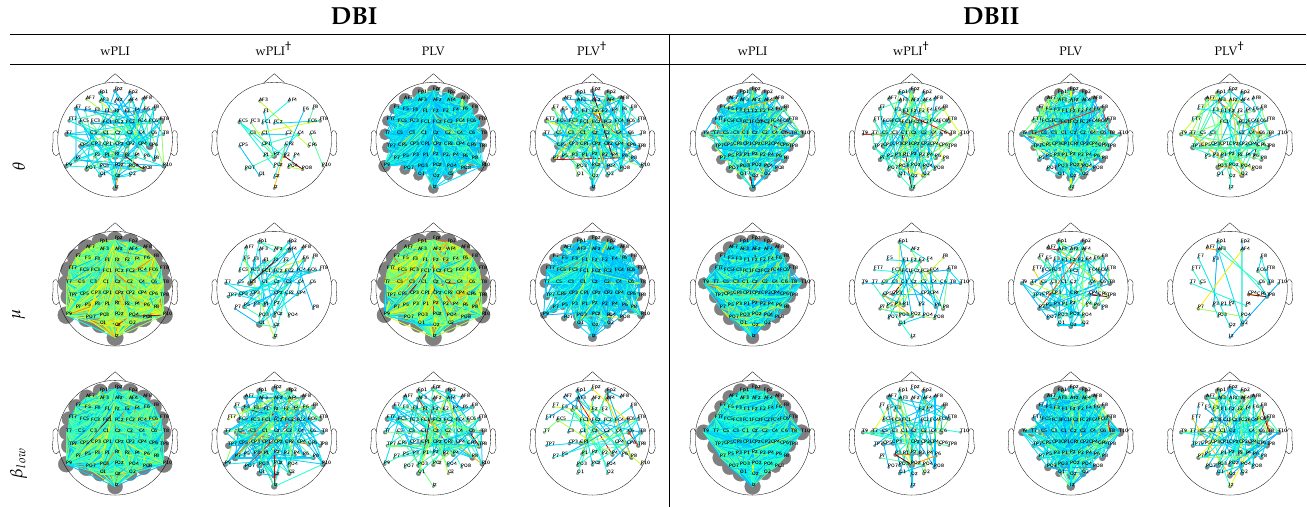
Figure 4. DNR weights mostly supporting the prediction performance, learned for wPLI and PLV predictors using two validation scenarios: leave-one-out cross-validation and leave-one-out cross-validation with Monte Carlo dropout (noted with †